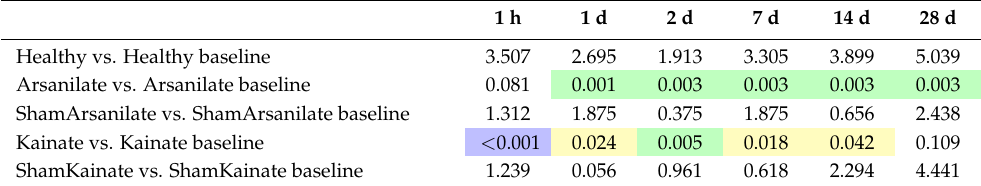
Table A6. Bonferroni-corrected p values for average tilt point angle to xz plane during immobility (one- sided Wilcoxon test; p values lower than 0.05, 0.01 and 0.001 are highlighted in yellow, green and blue, respectively).